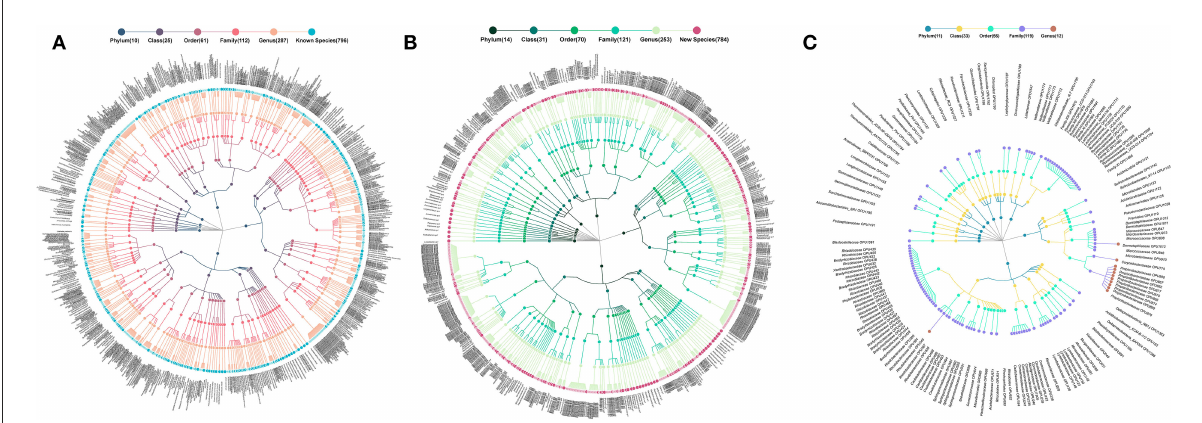
FIGURE1 Taxonomic profiles of human ocular surface microbiota. (A) 796 cultured species, (B) 784 potentially new species, and (C) 151 potentially higher taxa. *Each dot represents an OPU. The descending hierarchical levels are expressed from the inner to the outer rings. The total number of OPUs at different hierarchical levels is displayed in brackets.